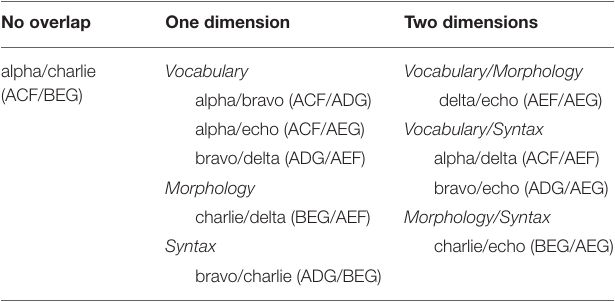
TABLE 1 | Summary of the degree of overlap (zero/one/two dimensions), and domains of similarity (vocabulary/morphology/syntax) across the ten possible language